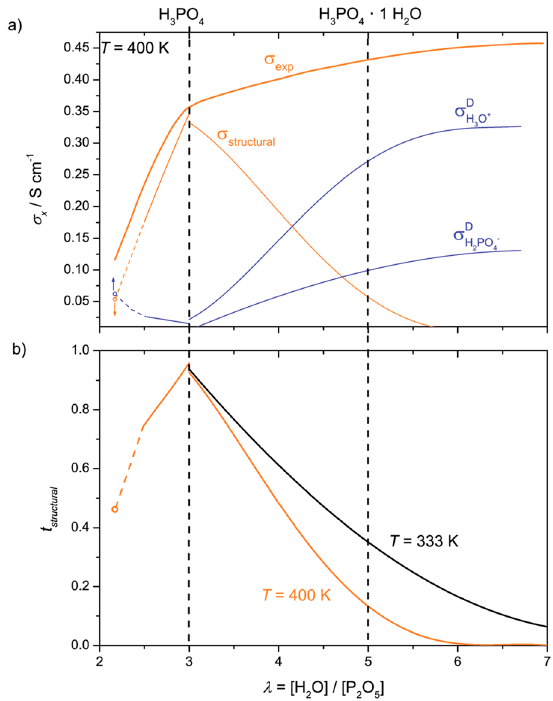
Figure 9. ( a ) Total proton conductivity, σ exp , of phosphoric acid as a function of λ and its contributions from proton structural diffusion, σ structural , and ionic transport associated with the hydrodynamic background σ vehicle ; ( b ) The corresponding structural transference numbers at different temperatures (taken from Ref. [82]).